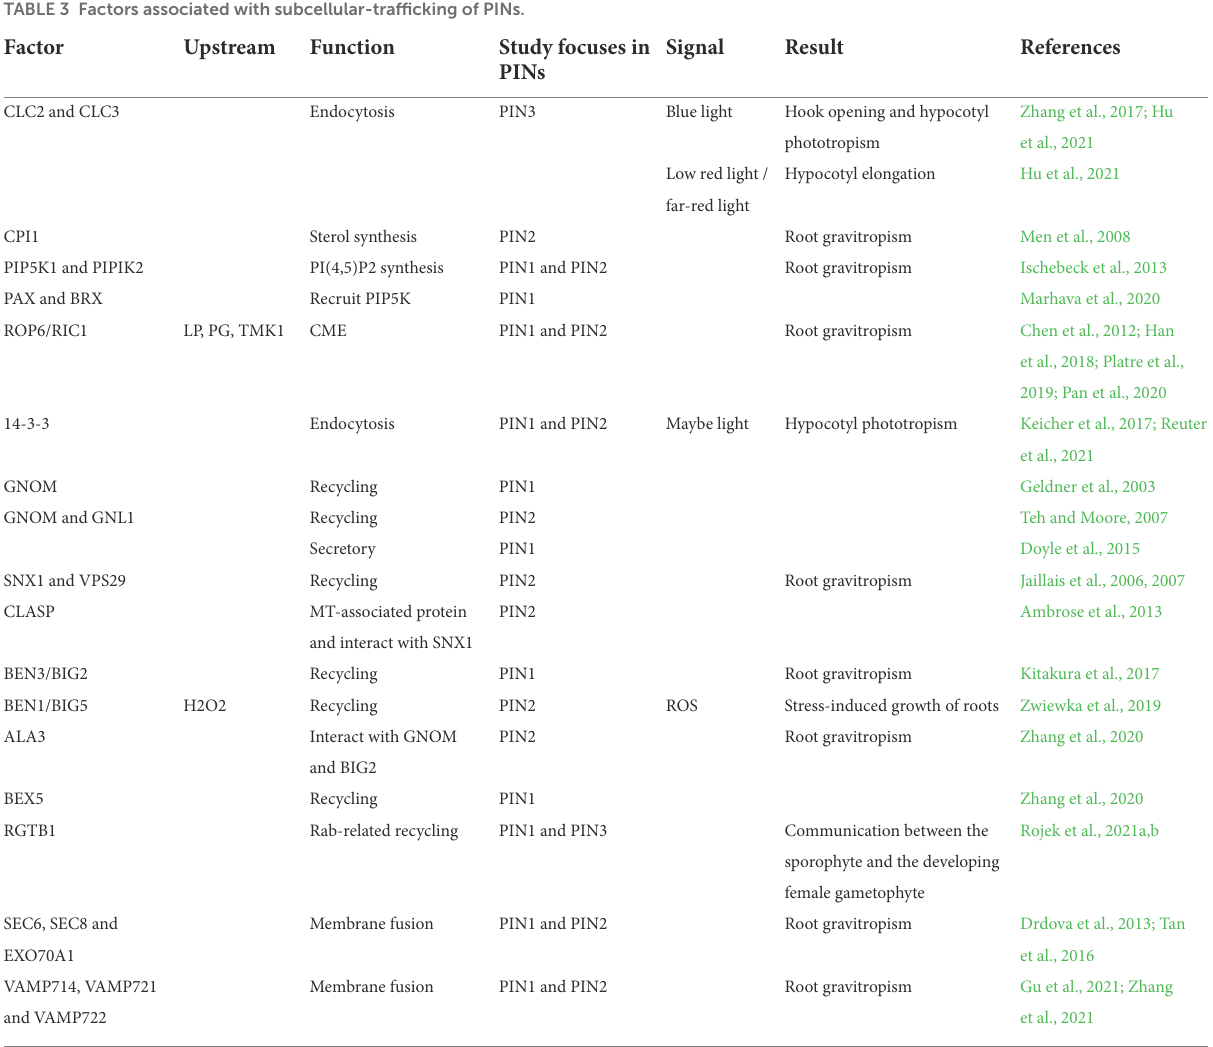
TABLE 3 Factors associated with subcellular-trafficking of PINs.